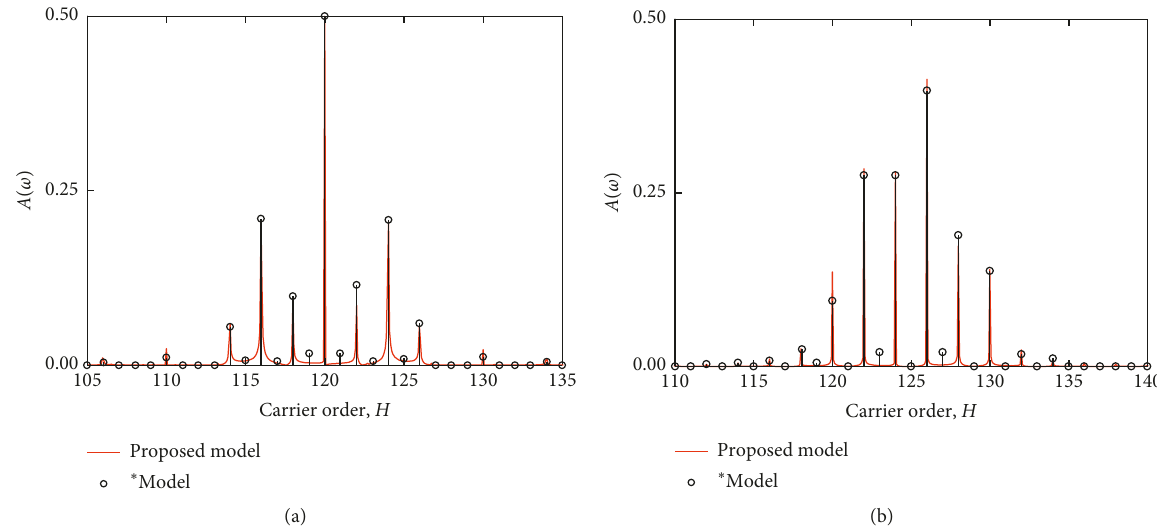
Figure 5: Acceleration spectra on the ring gear for (a) N � 4, z z s � 73 with φ � 0, 0.505 π , π , and 1.505 π . ∗ Model from Inalpolat and Kahraman